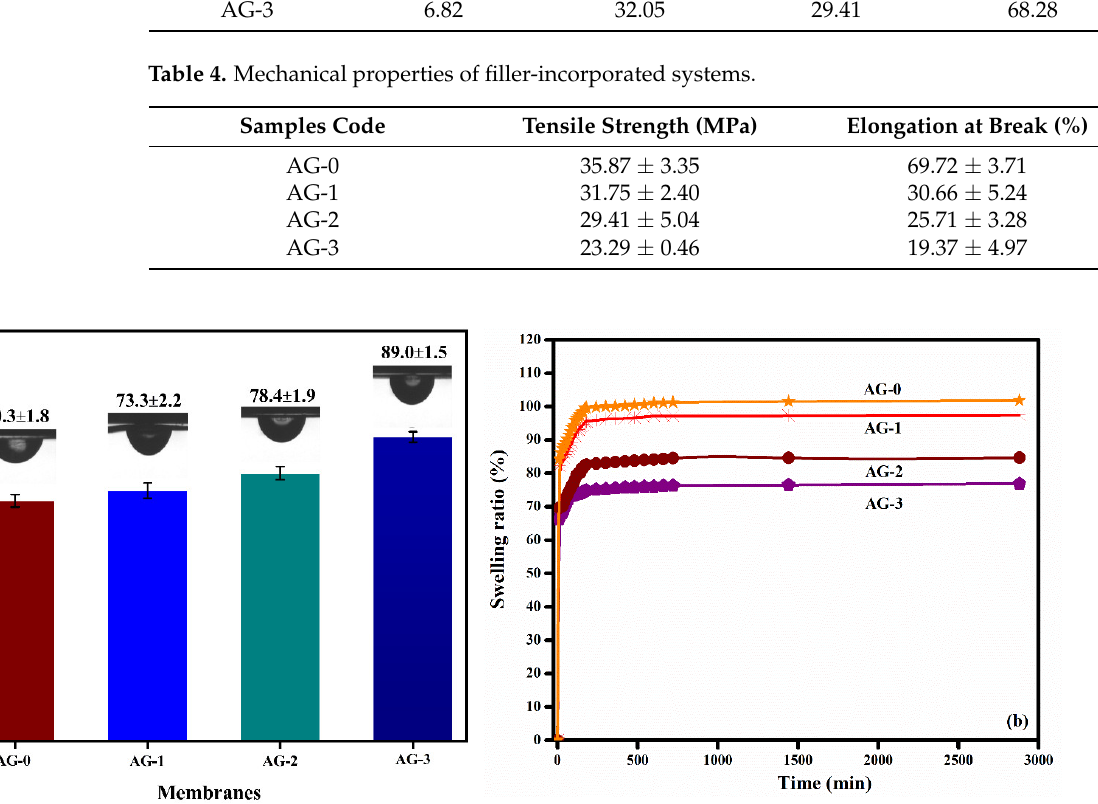
Figure 7. Optical microscopy images of biomembrane: ( a ) AG-0; ( b ) AG 1; ( c ) AG-2; ( d ) AG-3.